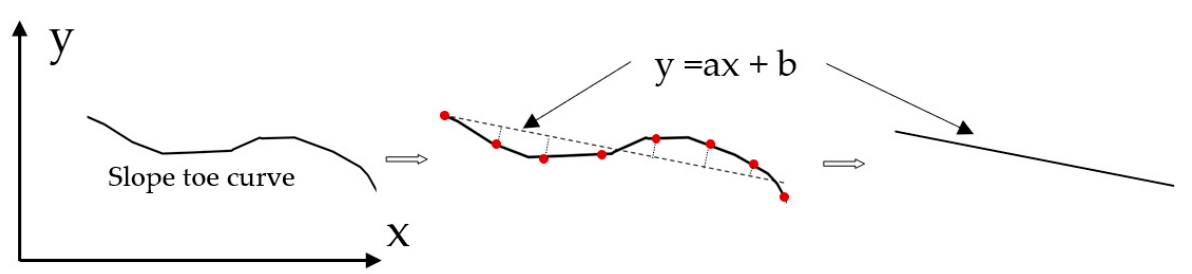
Figure 7. Slope toe simplification: the diagram shows how the broken line is finally reduced to a straight line by line fit- ting.